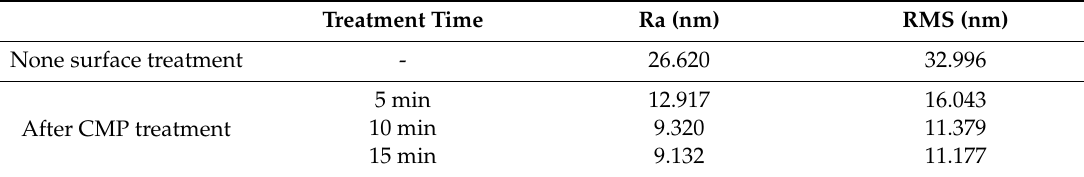
Table 2. Photovoltaic performance parameters (J SC , V OC and Fill Factor, and PCE).